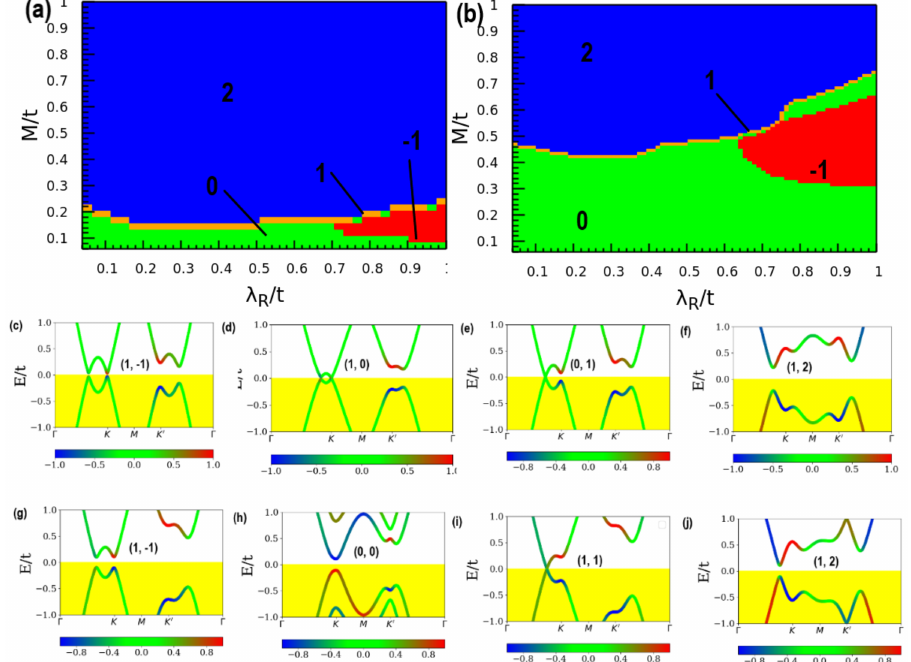
Figure 3. Chern number phase diagram as the function of staggered sublattice potential µ 1 = 0.1 t ( a ). µ 2 = 0.3 t ( b ). Where green denotes C = 0, blue denotes C = 2, red denotes C = − 1 and yellow denotes C = 1, respectively. The band structure derived for unique quantum phases at 0.1 t are plotted for Chern numbers: − 1 ( c ),0 ( d ), 1 ( e ), 2 ( f ). The corresponding band structure for unique